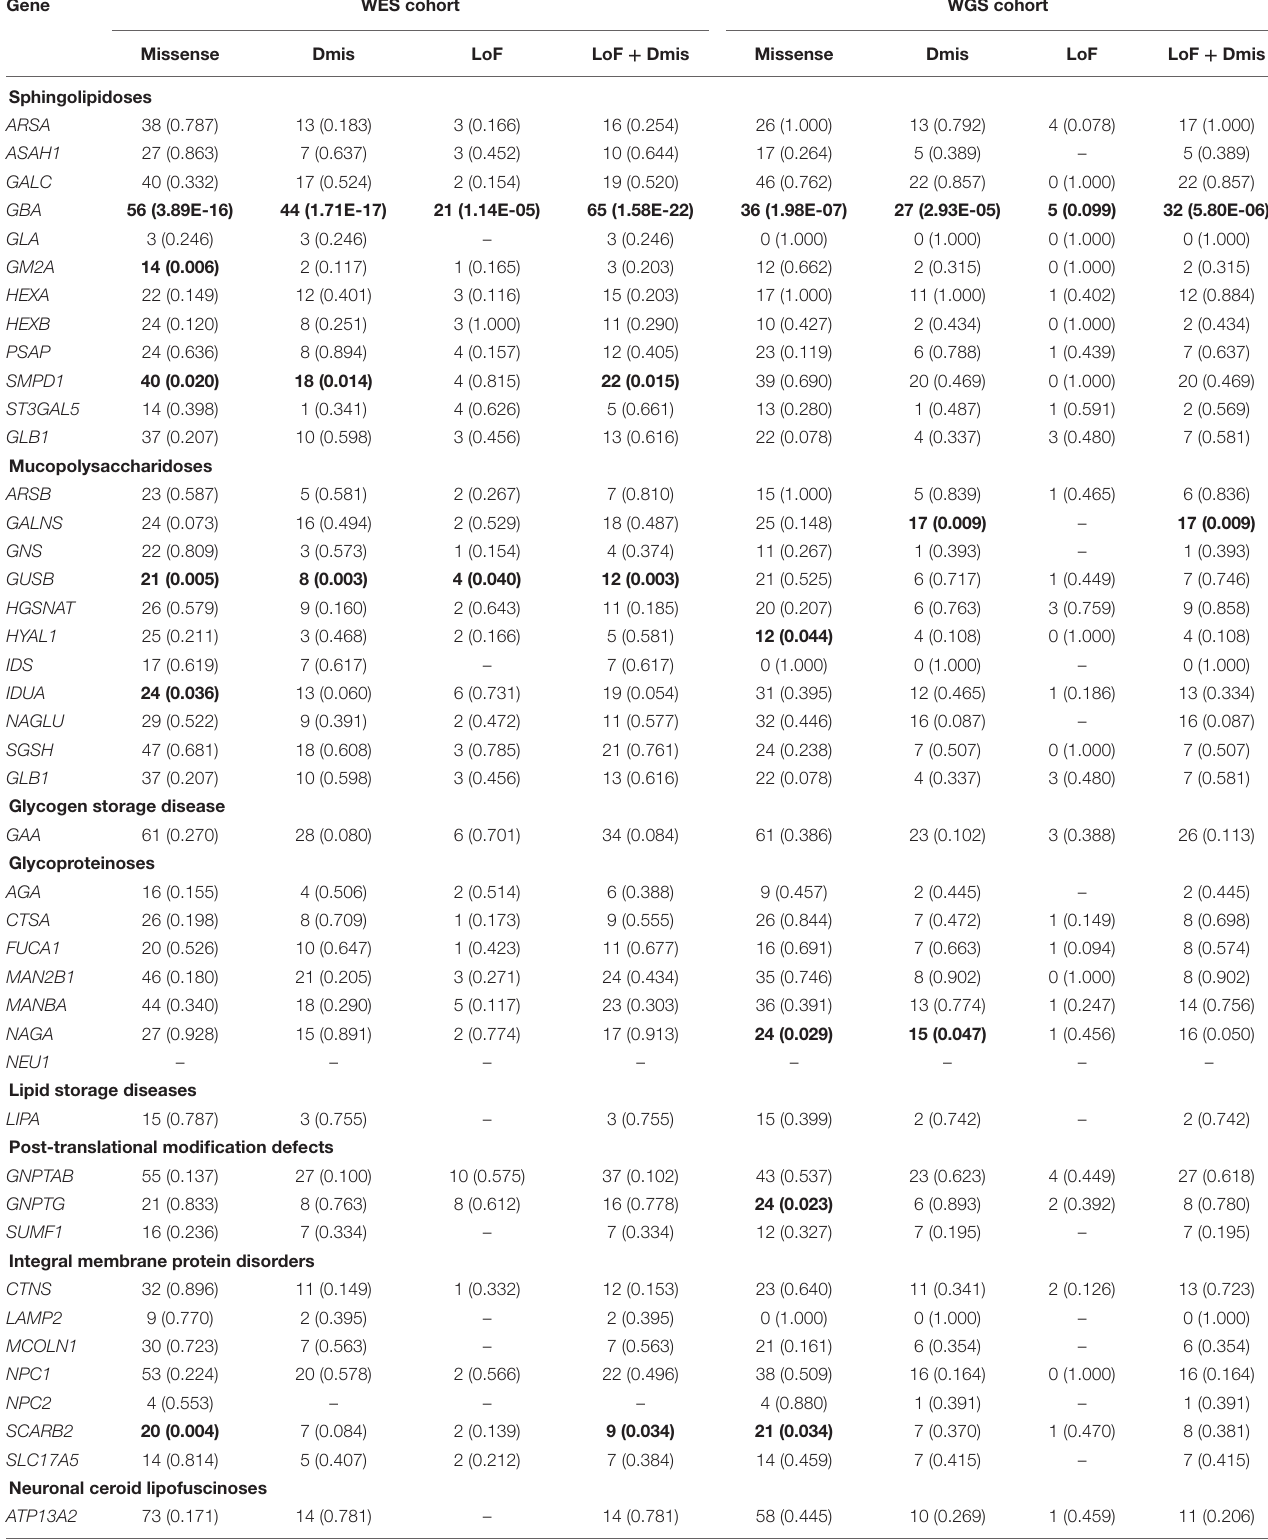
TABLE 3 | Analysis of rare variant burden within each LSD associated gene in PD (MAF < 1%). Gene WES